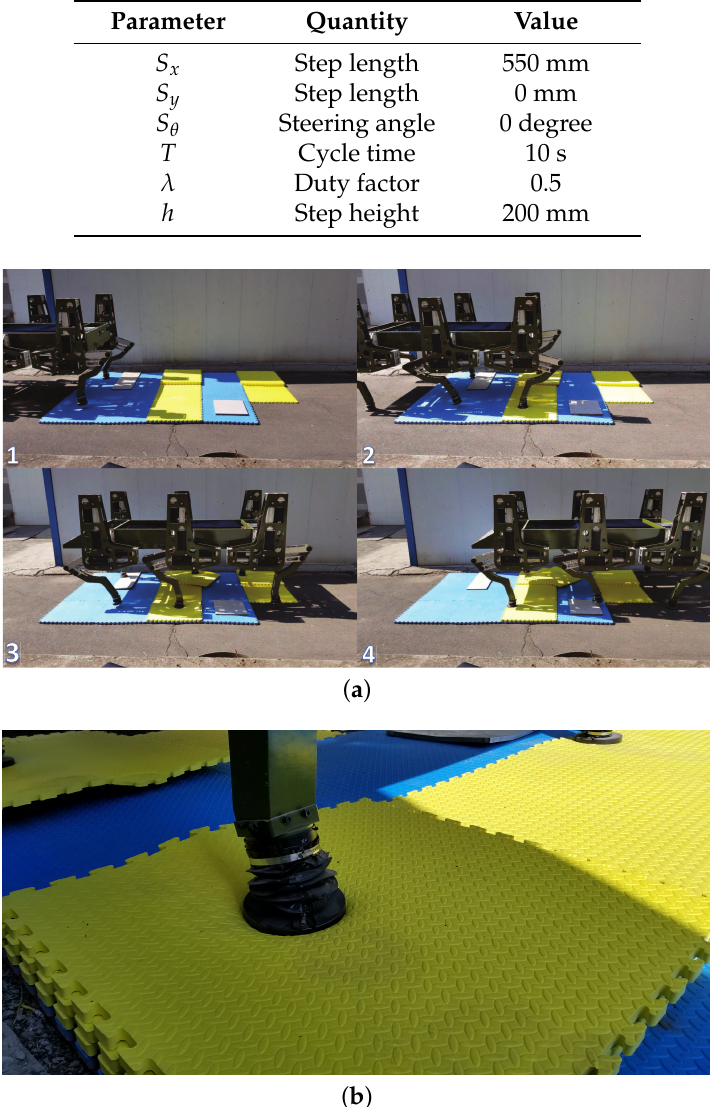
Figure 10. The snapshots of the artificial soft terrain walking experiment: ( a ) the artificial soft terrain walking process and ( b ) the deformation of the artificial soft